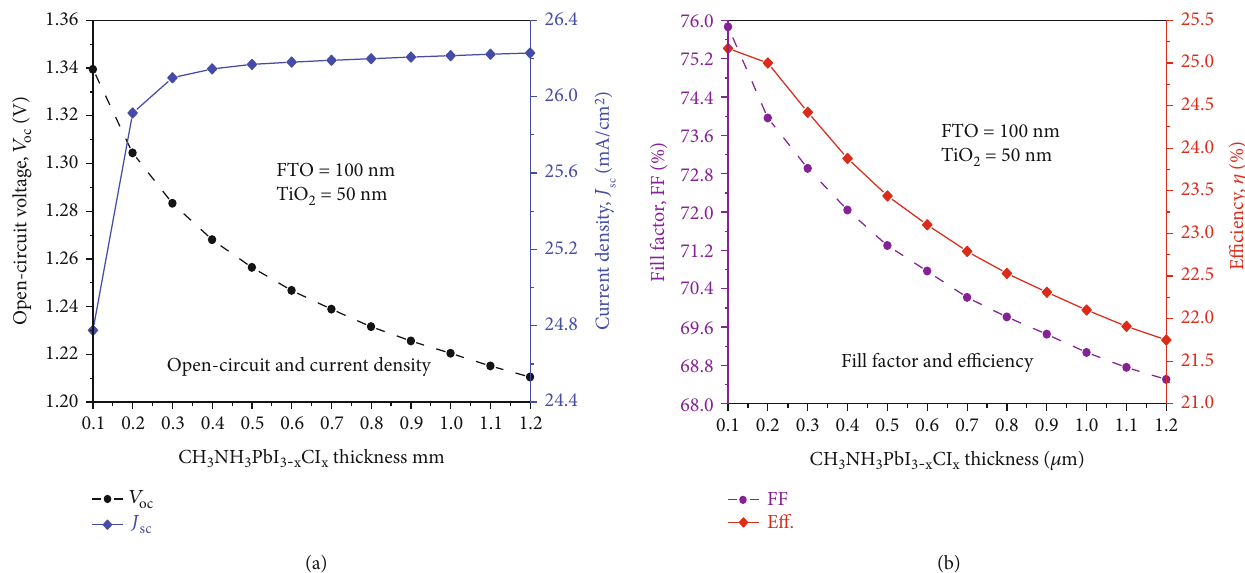
Figure 5: (a) Open-circuit and current density (b) fi ll factor and e ffi ciency as functions of CH TiO thicknesses. 2